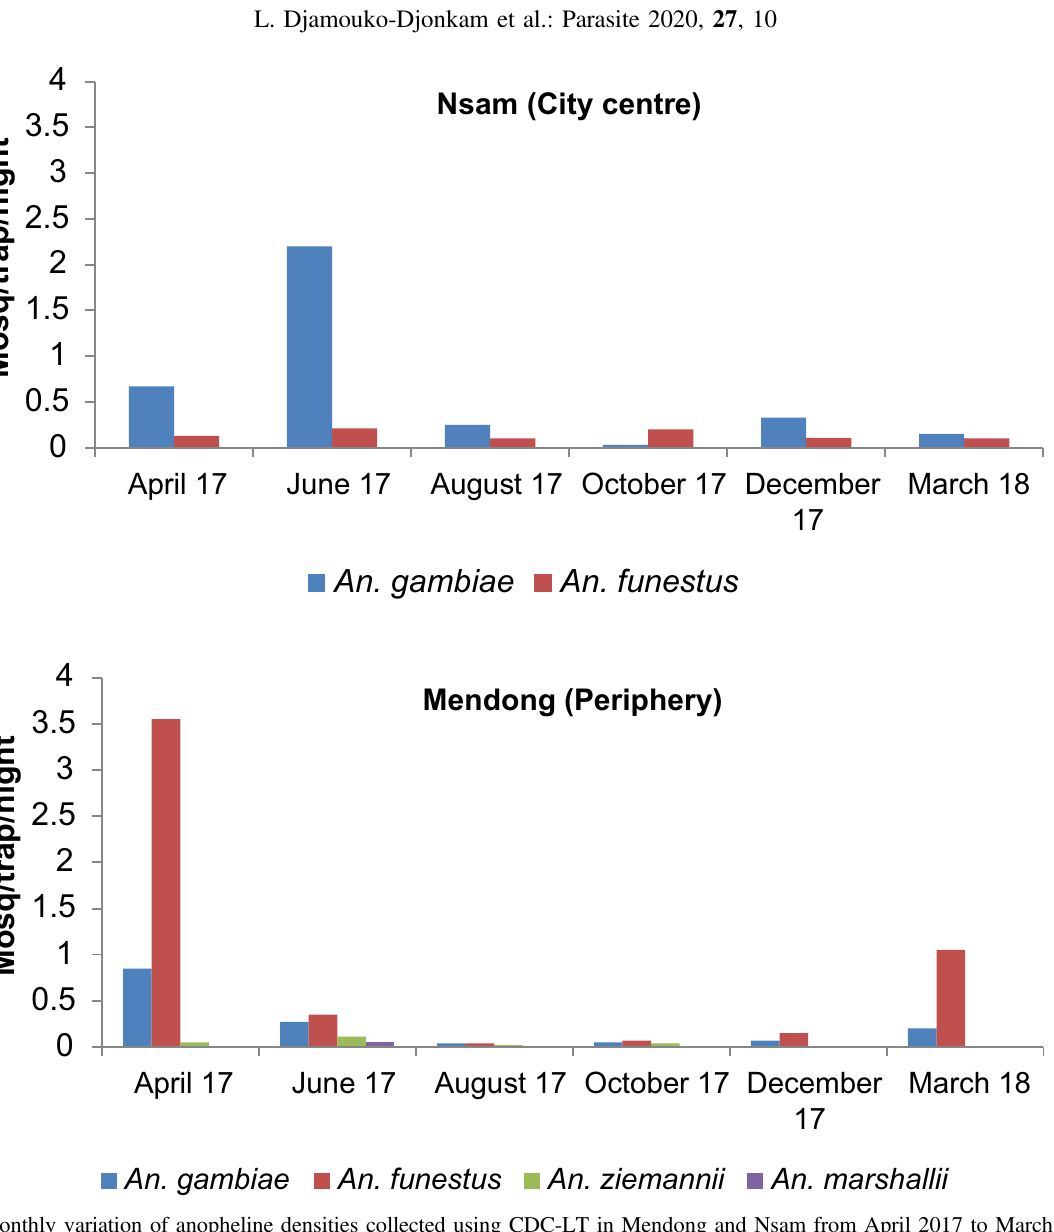
Figure 3. Monthly variation of anopheline densities collected using CDC-LT in Mendong and Nsam from April 2017 to March